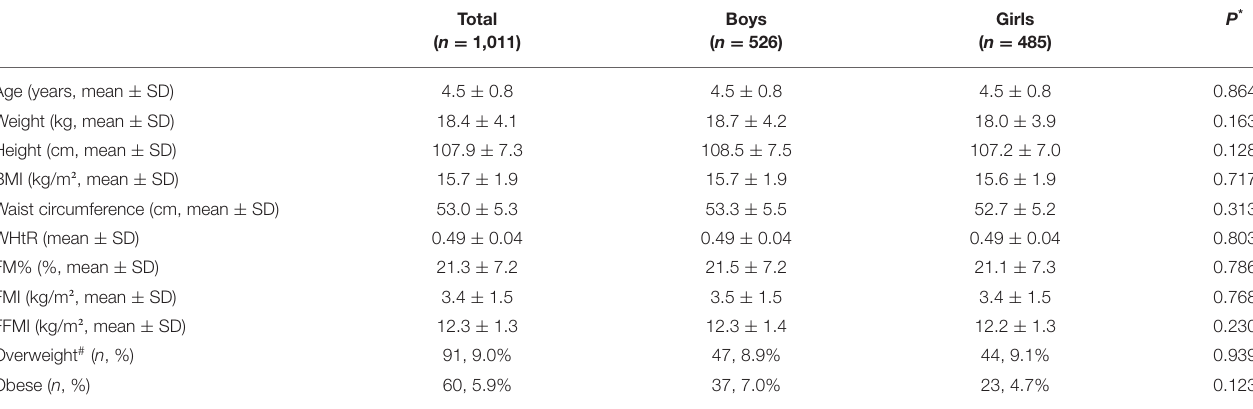
TABLE 1 | Characteristics of study